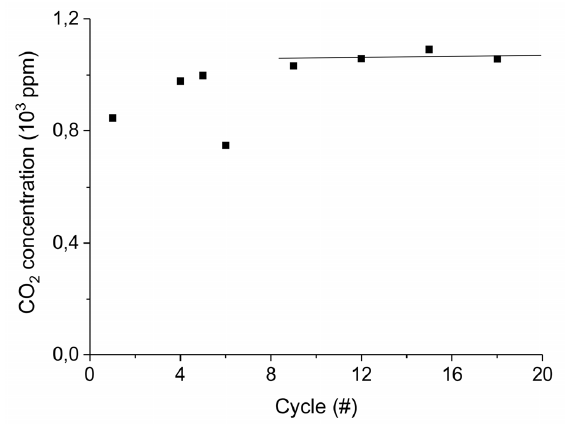
Figure A15. CO 2 concentration at the first stage of decomposition of 10 mg CaCO 3 for different cumulative number of cycles. The decompositions are performed at standard conditions, i.e., 630 °C without plasma in absence of CO 2 in the gas mixture.